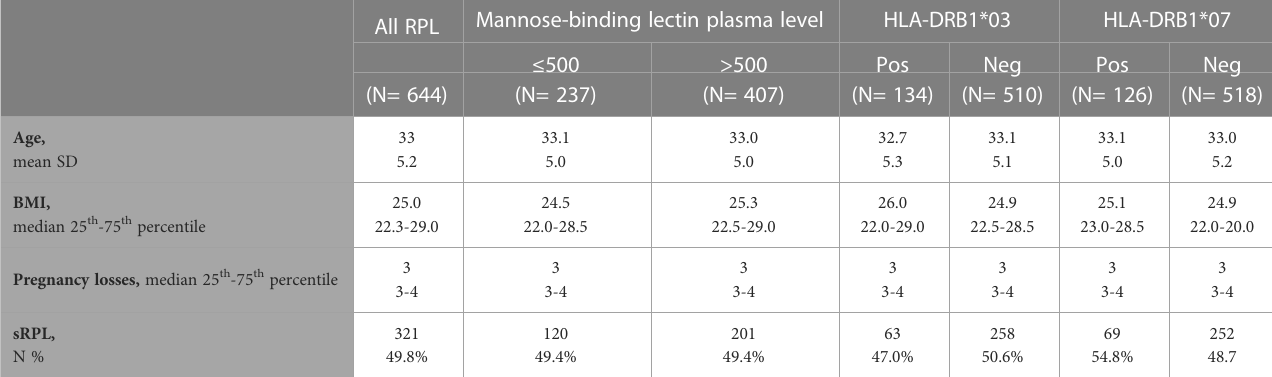
RPL, recurrent pregnancy loss; sRPL, secondary recurrent pregnancy autoantibodies in patients with low p-MBL level compared to normal p-MBL level (p=0.14) and in patients with minimum one HLA-